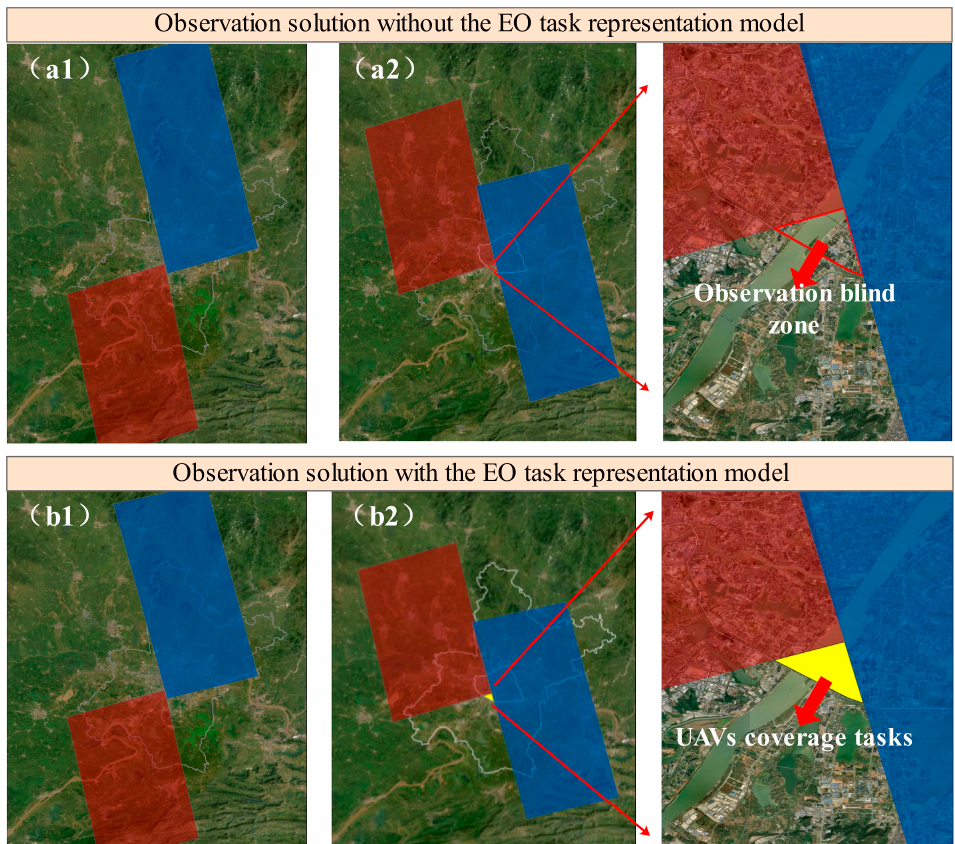
Figure 12. Effect of observation task observation representation model on the observation coverage. ( a1 , b1 ) Coverage of unchanged task demands, ( a2 ) observation solution without EObTask after task demand change, ( b2 ) observation solution with EObTask after task demand change.